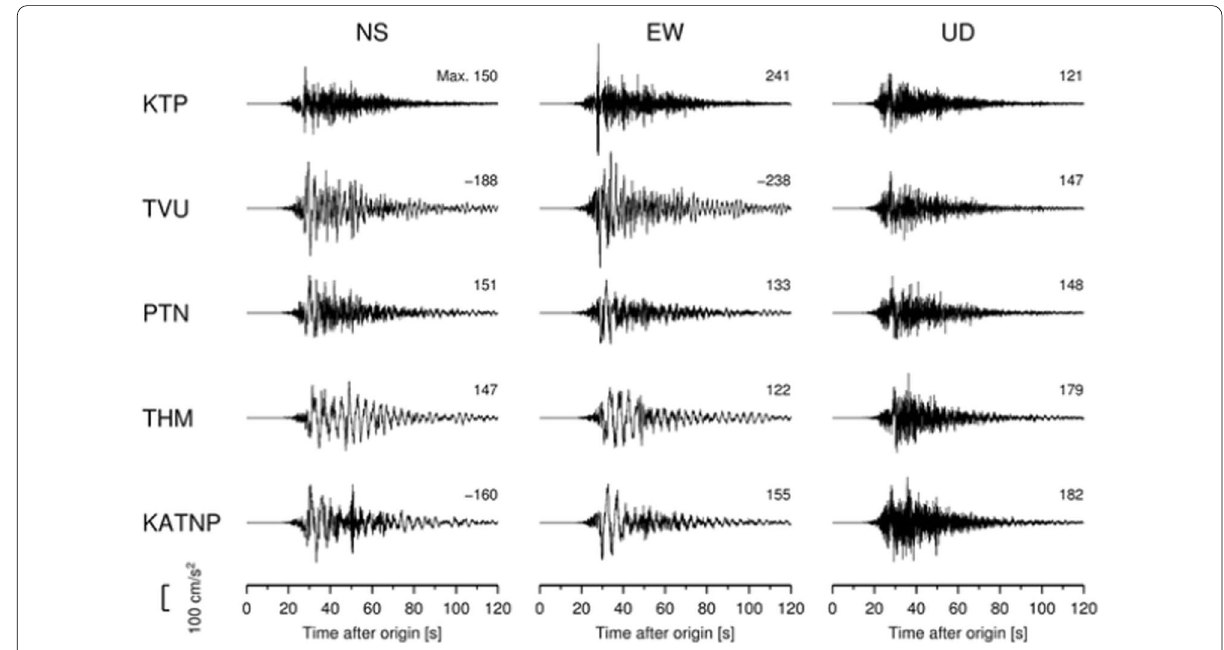
Fig. 2 Observed ground accelerations at one rock site (KTP), three sedimentary sites (TVU, PTN, and THM) by Takai et al. (2016), and one sedimentary site (KATNP) by USGS (2015) (Reprinted from Takai et al.